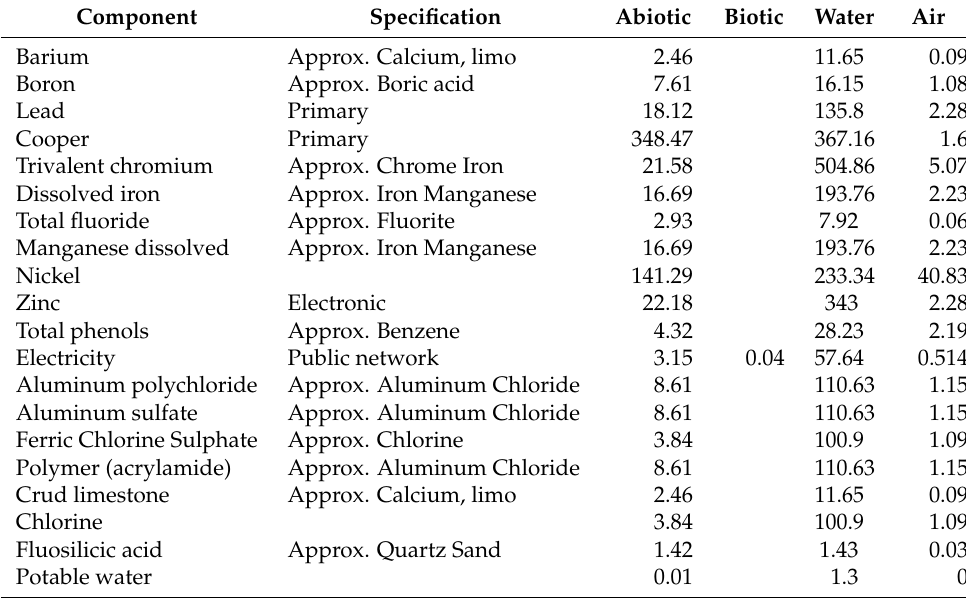
Table 2. Factor of intensity of the materials involved in the